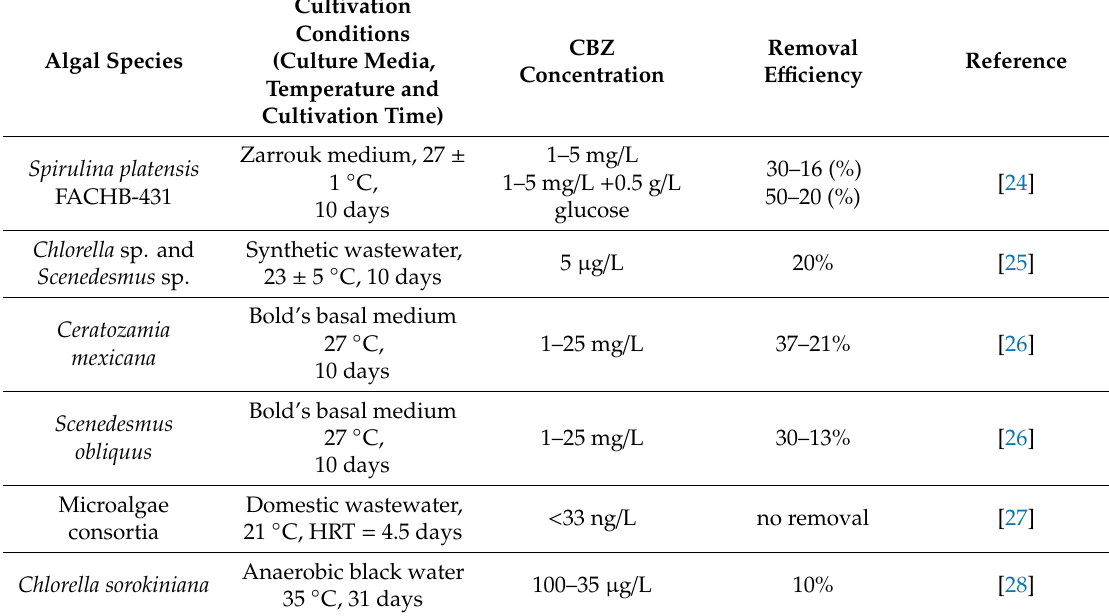
Table 2. Removal of carbamazepine (CBZ) from aqueous solutions by